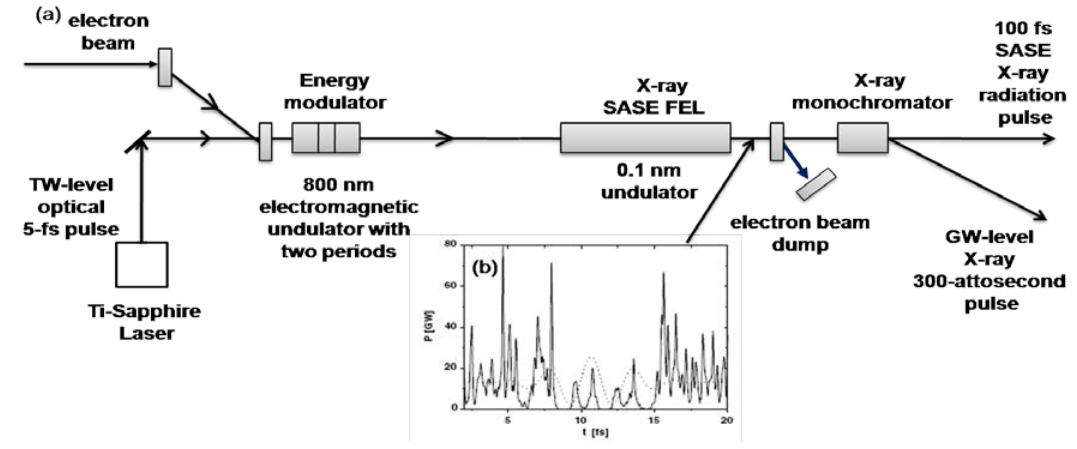
Figure 2. (Color online). Attosecond enhanced self-amplified spontaneous emission (SASE) (ESASE) scheme. ( a ) The layout of the scheme. ( b ) The single shot temporal structure of the central part of the radiation pulse. Dotted line represents the energy modulation of electron bunch